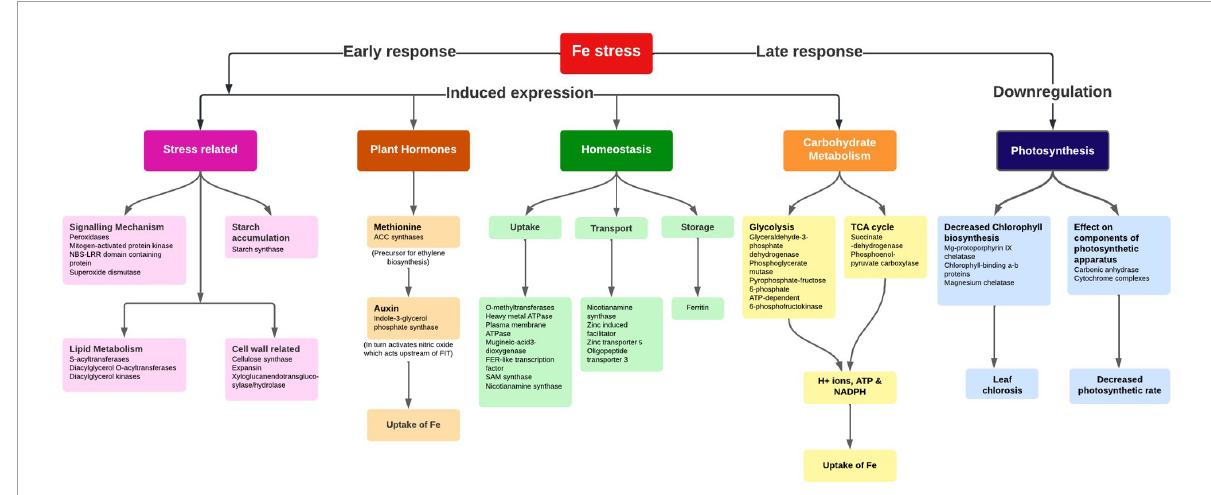
FIGURE6 Important pathways and their interconnectivity in response to Fe stress in pearl